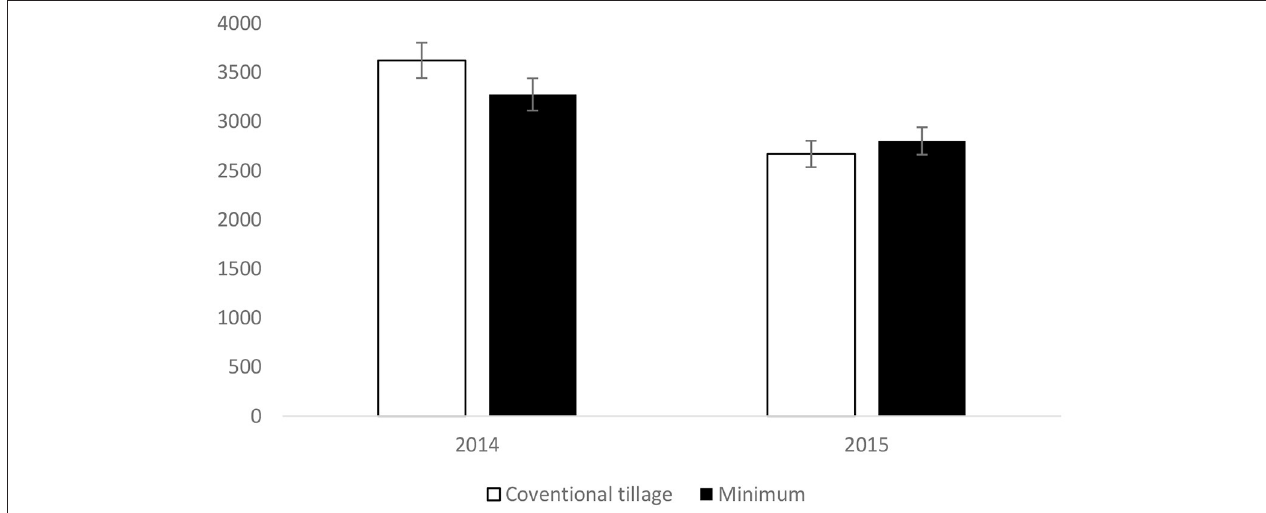
FIGURE 4 | Cumulative CO 2 emissions in spring wheat as affected by conventional tillage (hollow bars) and minimum tillage (filled bars). Data re-plotted from Yeboah et al.